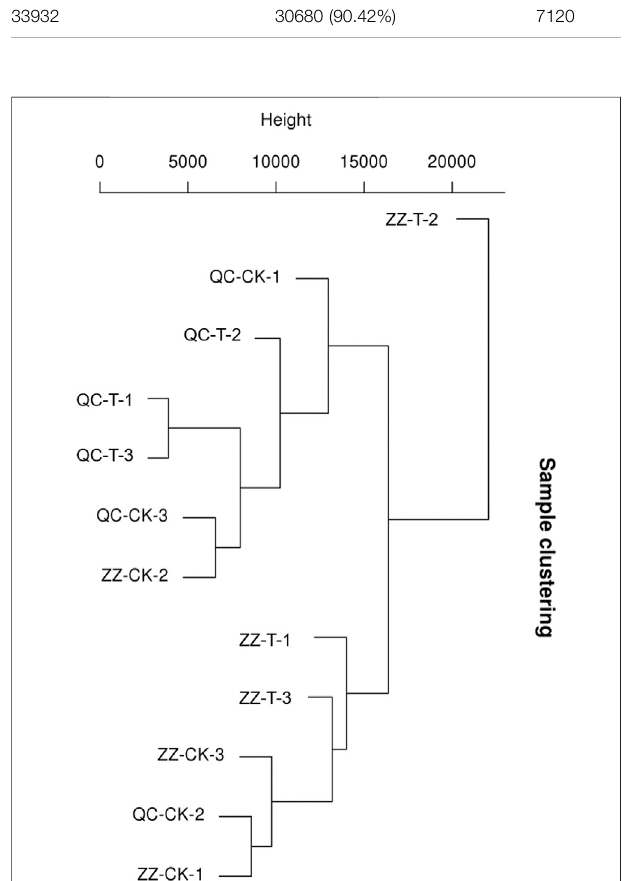
FIGURE2| SampleClusterDiagram.QC,Cuttingteaplant.ZZ,Seeding tea plant. CK: Cutting samples treated with drought for 0 days, T: Cutting samples treated with drought for 20